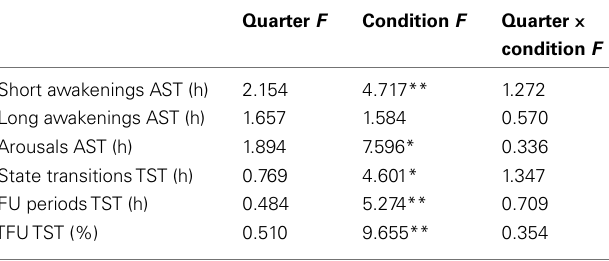
Table 5 |Time distribution of sleep fragmentation. Quarter F Quarter